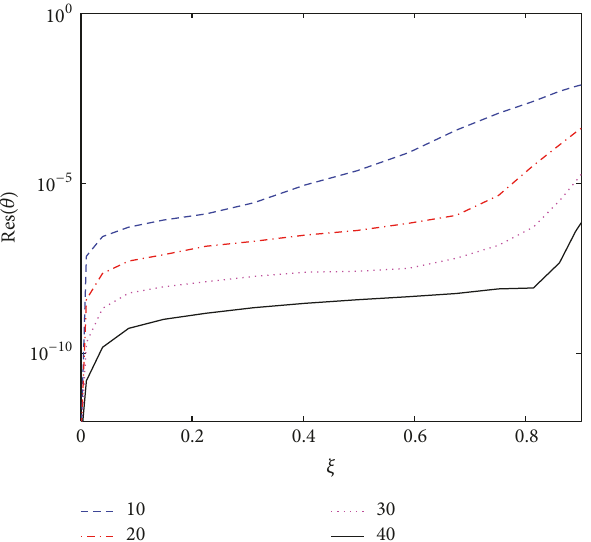
Figure 5: Residual error in 𝑓(𝜂,𝜉) against 𝜉 at different iteration levels ( 𝜆 = 1, 𝜎 = 𝛾 = 0.5, Pr = 3, Sc = 2, ℏ = −0.5 ).